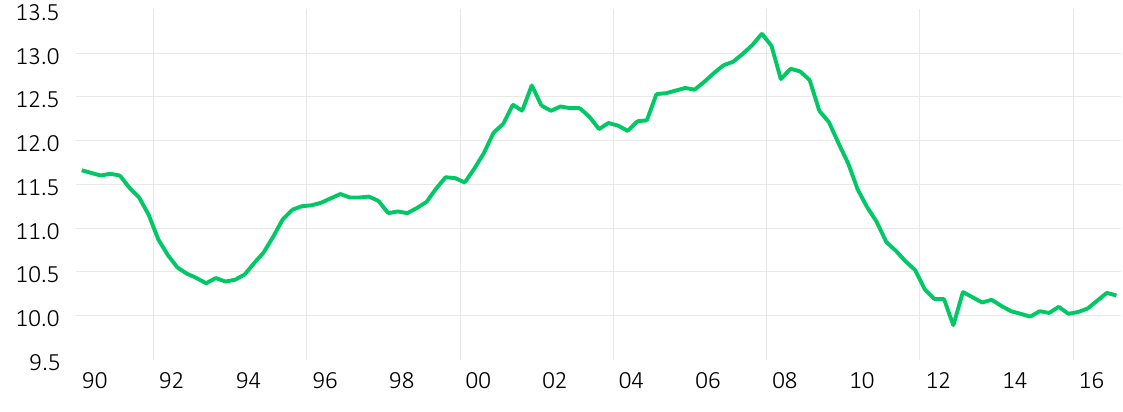
Figure 1. US household